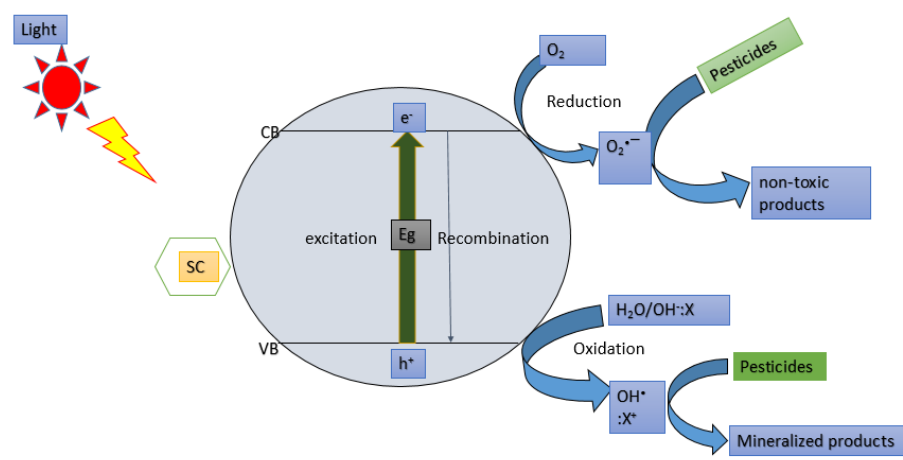
Figure 7. Mechanism of decomposition of pesticide involving heterogeneous photocatalysis.